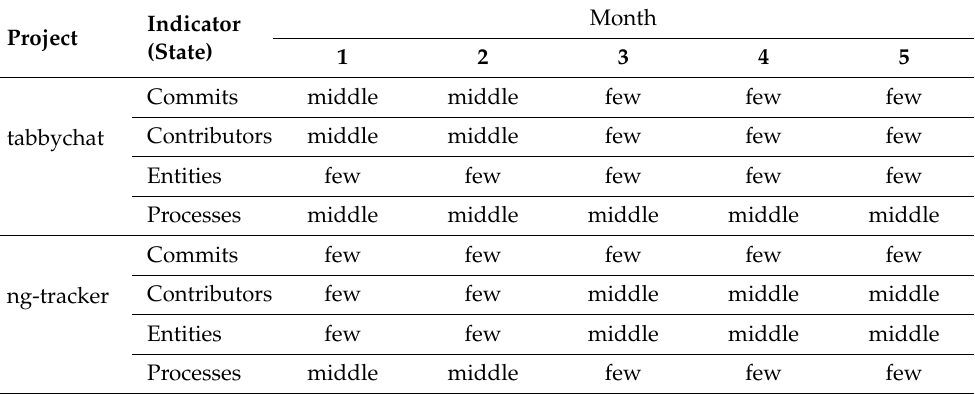
Table 2. States of indicators of analyzed